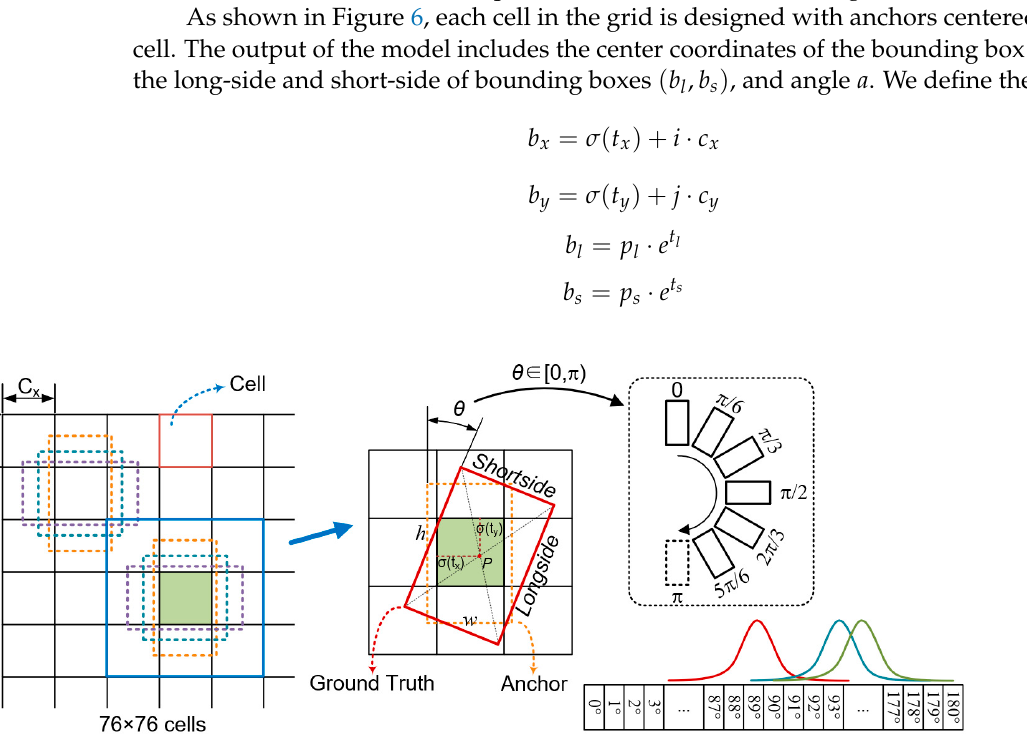
Figure 6. Bounding boxes with angle prediction.